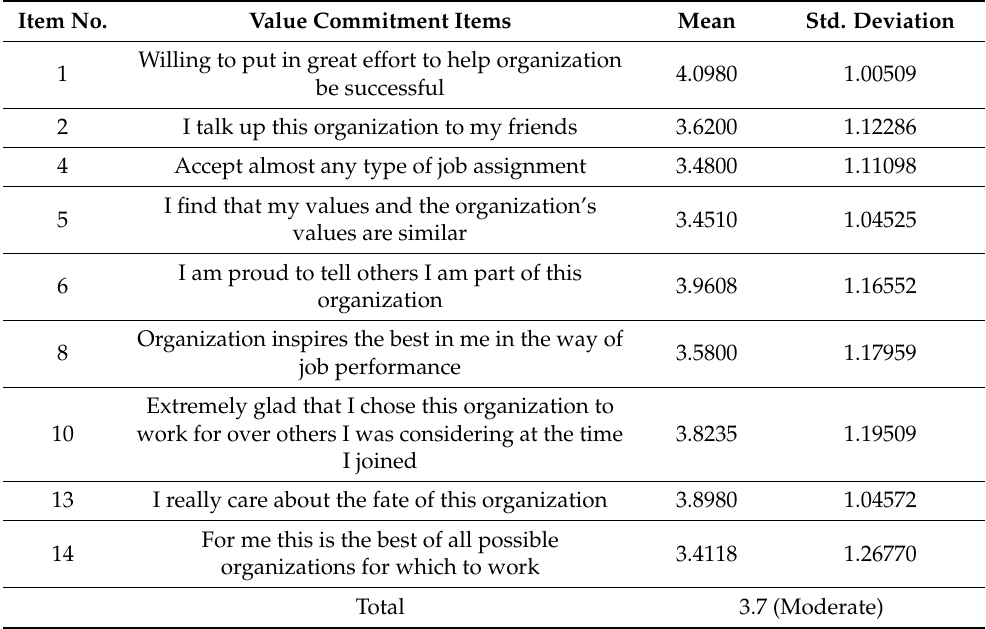
Table 4. The mean and standard deviation of the organizational commitment subscale (value com-